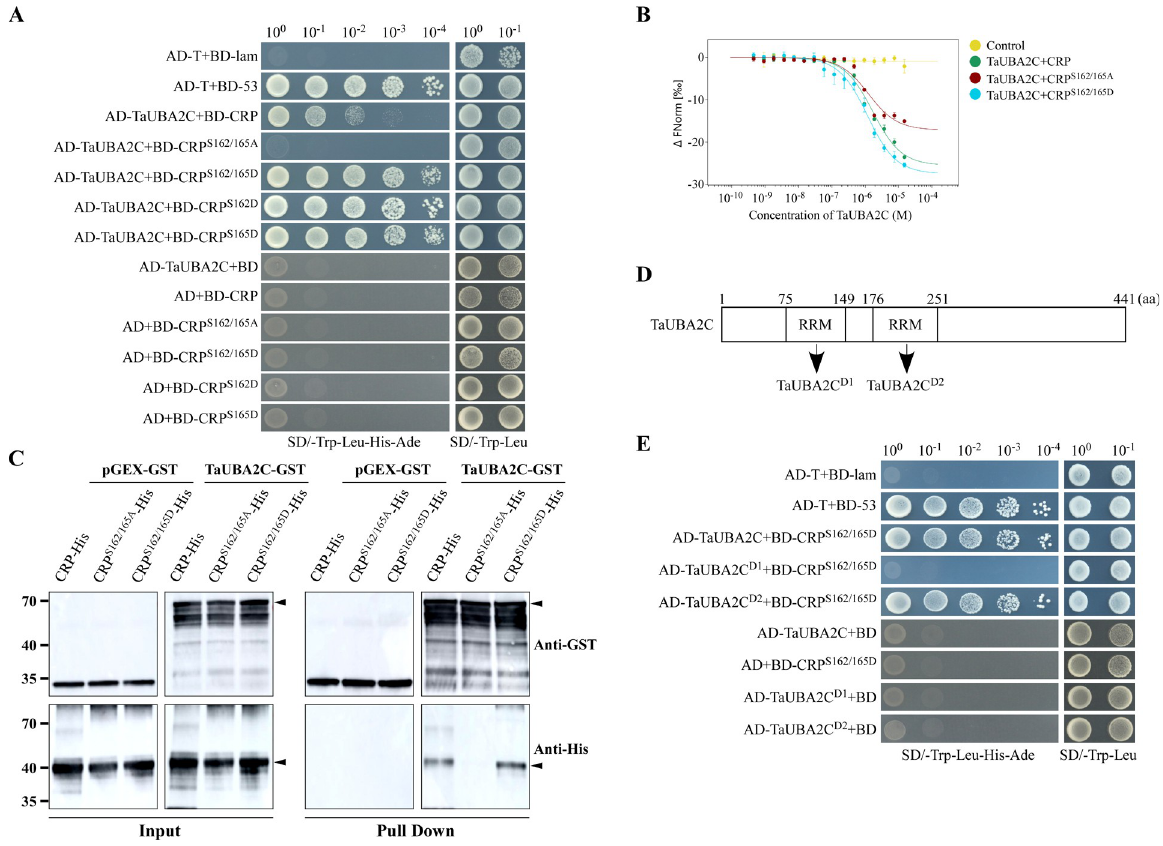
Fig 5. CWMV CRP S162/165D can interact with TaUBA2C. A. YTH assay was used to detect the interaction between TaUBA2C and CRP, CRP S162/165A , CRP S162/165D , CRP S162D or CRP S165D . AD-TaUBA2C and BD-CRP or one of its derivatives were co-expressed in yeast cells. The transformed yeast cells were grown on the SD/-Leu/-Trp medium and then on the SD/-Trp/-Leu/-His/-Ade medium. Yeast cells co-expressing AD-T+BD-Lam or AD-T+BD-53 were used as controls. B. Microscale thermophoresis assay was used to detect the binding affinity of TaUBA2C to CRP, CRP S162/165A or CRP S162/165D . Three independent experiments were conducted in this study and yielded similar results. Bars represent standard errors. C. Pull-down assay was used to confirm the in vitro interaction between TaUBA2C-GST and CRP-His, CRP S162/165A -His or CRP S162/165D -His. In this study, GST was used as a control. Black arrowheads indicate the positions of TaUBA2C-GST, CRP-His, CRP S162/165A - His, and CRP S162/165D -His, respectively. D. A schematic shows the arrangement of domains in TaUBA2C. The numbers above the schematic indicate the amino acid positions of different domains. RRM, RNA-recognition motif; aa, amino acids. E. YTH assay was used to detect the interaction between CRP and TaUBA2C, TaUBA2C D1 or TaUBA2C D2 .